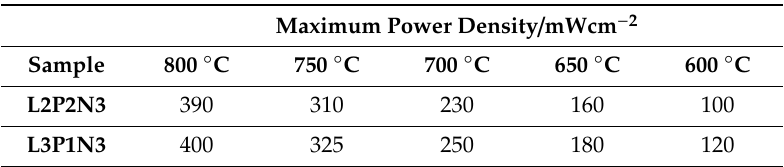
Table 4. Maximum power densities obtained from single-cell measurements using the L2P2N3 and L3P1N3 cathodes as a function of measurement temperature.